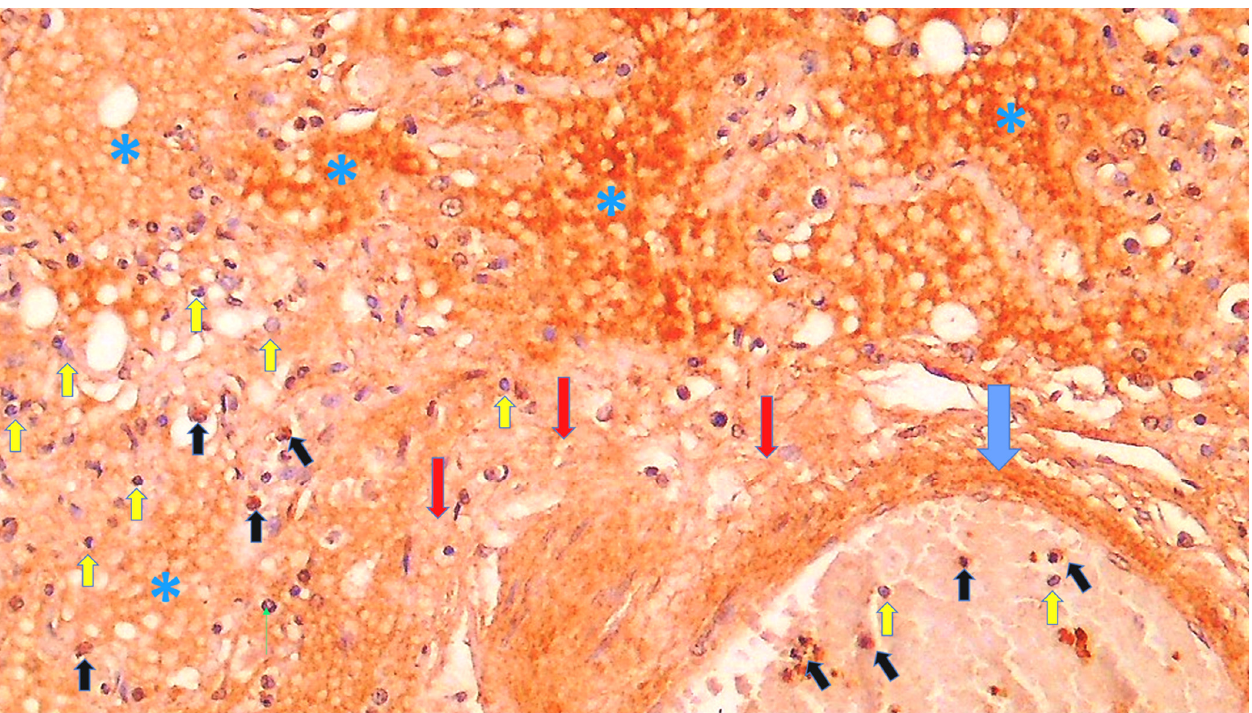
Figure 9. Immunohistochemistry for 4-HNE protein adducts in the lungs of a COVID-19 patient with pneumonia and DAD. There is a marked immunohistochemical positivity for 4-HNE present in the vessel wall (blue arrow), edematous fluid (asterisks), and interstitial stroma (red arrows). Some PMNs within the blood vessel and inflammatory cells in lung tissue are also positive (black arrows), while the majority are negative for 4-HNE, contrast-stained blue by hematoxylin (yellow arrows) (DAB, 600×).